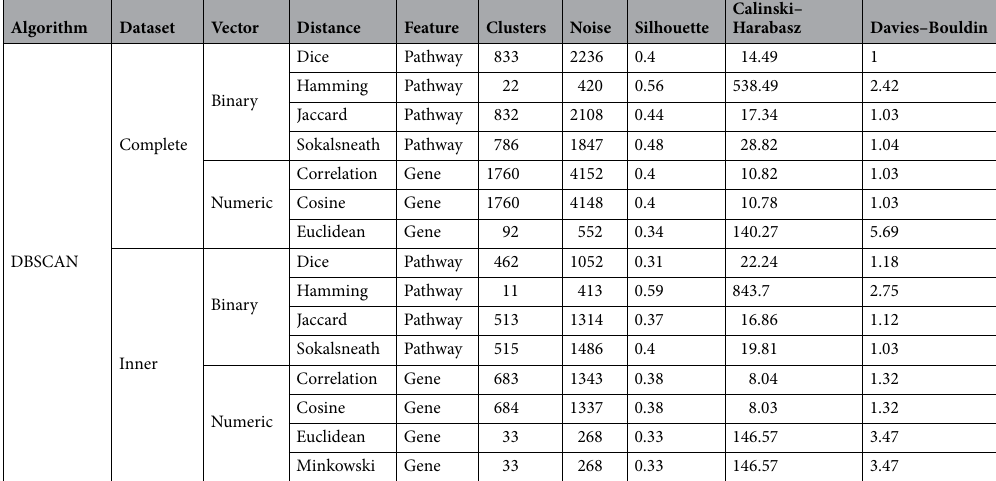
Table 1. Best results obtained when performing DBSCAN in the different datasets, with the different types of vectors and measuring diseases distance according to different metrics.